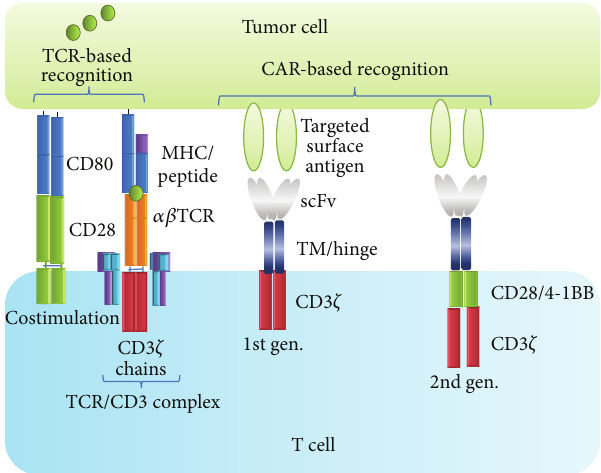
Figure 1: Elements involved in TCR and CAR recognition and activation. The TCR is disulfide-linked heterodimer consisting of one 𝛼 and one 𝛽 chain expressed in complex with invariant CD3 chains ( 𝛾,𝛿, 𝜁 , and 𝜀 ). The TCR recognizes intracellular or extracellular proteins presented as peptides by MHC molecules. CostimulationofCD28throughitsligands,CD80/CD86,isrequired for optimal activation and production of interleukin-2 (IL-2) and other cytokines. While most hematological tumors express costim- ulatory molecules, solid tumor cells as well as antigen presenting cells in the tumor microenvironment usually lack such molecules. CARs recognize surface antigens in an MHC unrestricted manner. CARs are fusion proteins between single-chain variable fragments (scFv) from a monoclonal antibody and one or more T cell receptor intracellular signaling domains. Various hinges and transmembrane (TM) domains are used to link the recognition and the signaling molecules [5]. While first generation CARs signaled through the CD3 𝜁 chain only, second generation CARs include a signaling domain from a costimulatory molecule, for example, CD28 (illus- trated), 4-1BB, OX40, CD27, or